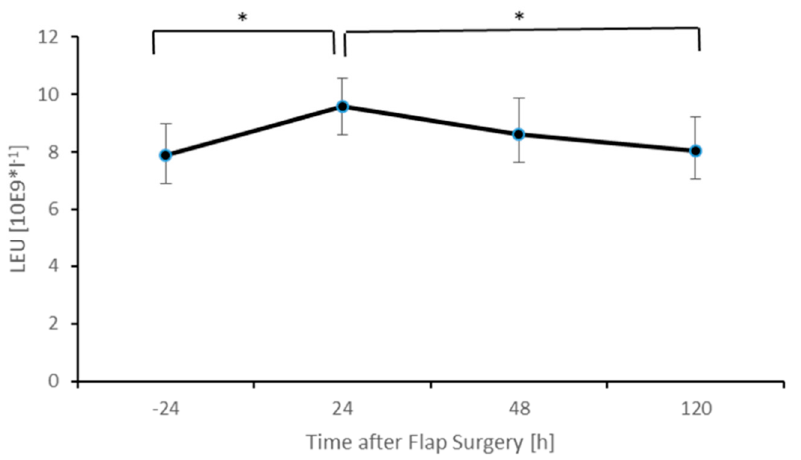
Figure 2. Postoperative levels of leukocytes. Columns indicate mean values; error bars refer to the corresponding standard deviations (* p ≤ 0.05).